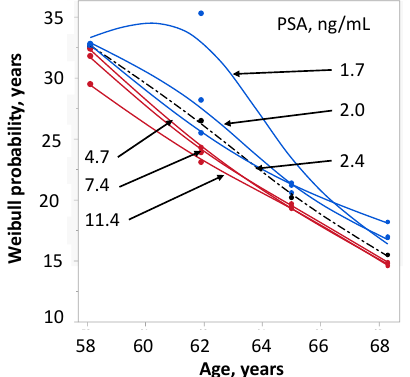
Figure 7. Influence of PSA concentration on survival probability of 175 men with prostate cancer stratified by age. The survival probability was calculated from Weibull-transformed Kaplan–Meier estimates. The shattered line shows the survival probability of age alone.